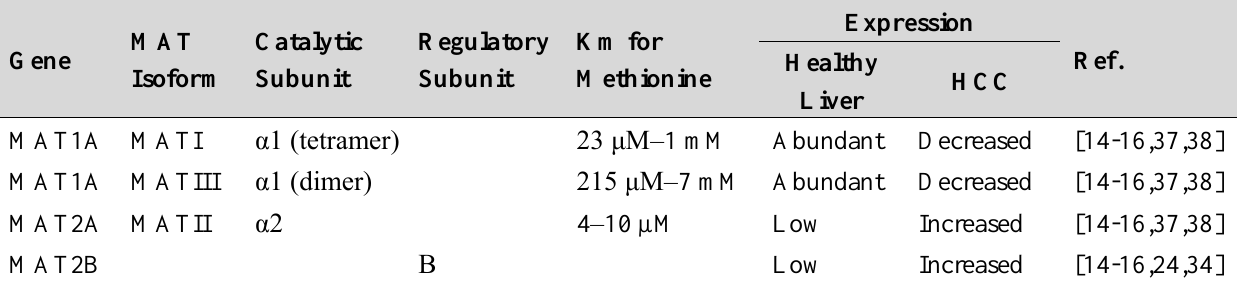
Table 1. MAT genes, isoenzymes, kinetics and expression